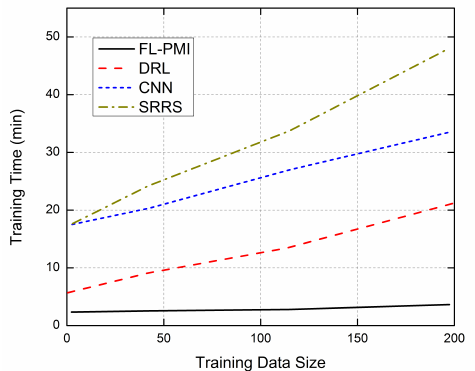
Figure 10. Comparative analysis of training time concerning training data